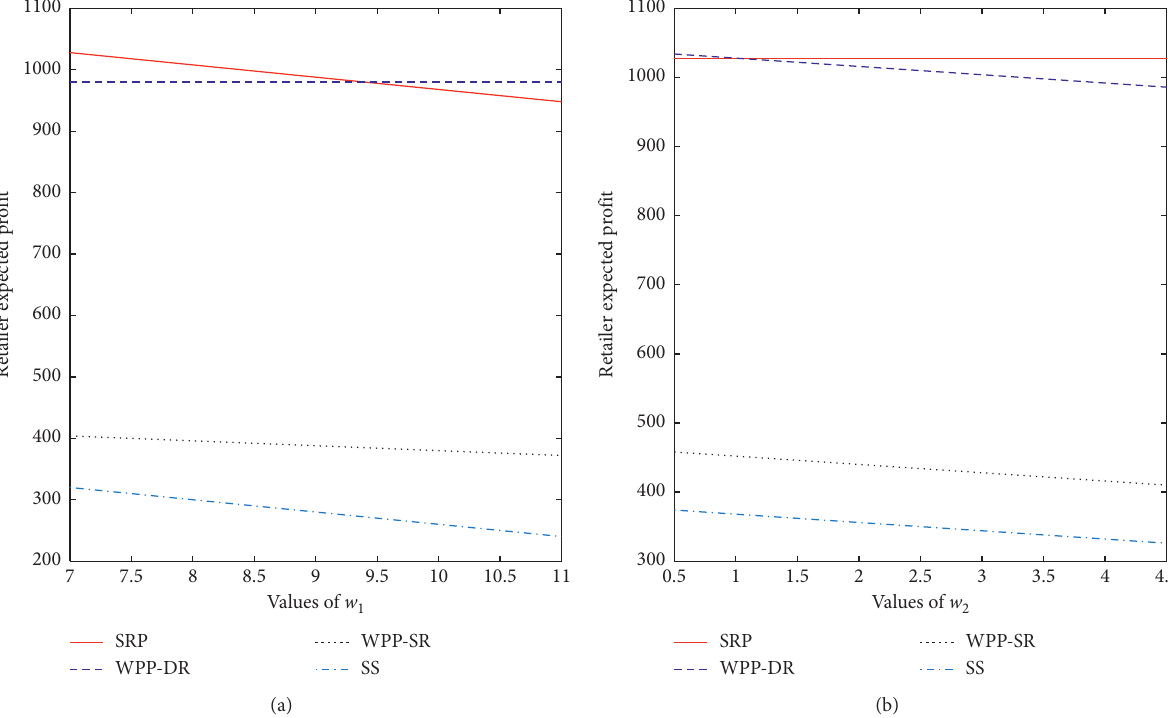
Figure 4: The retailer’s expected profit under different values of w